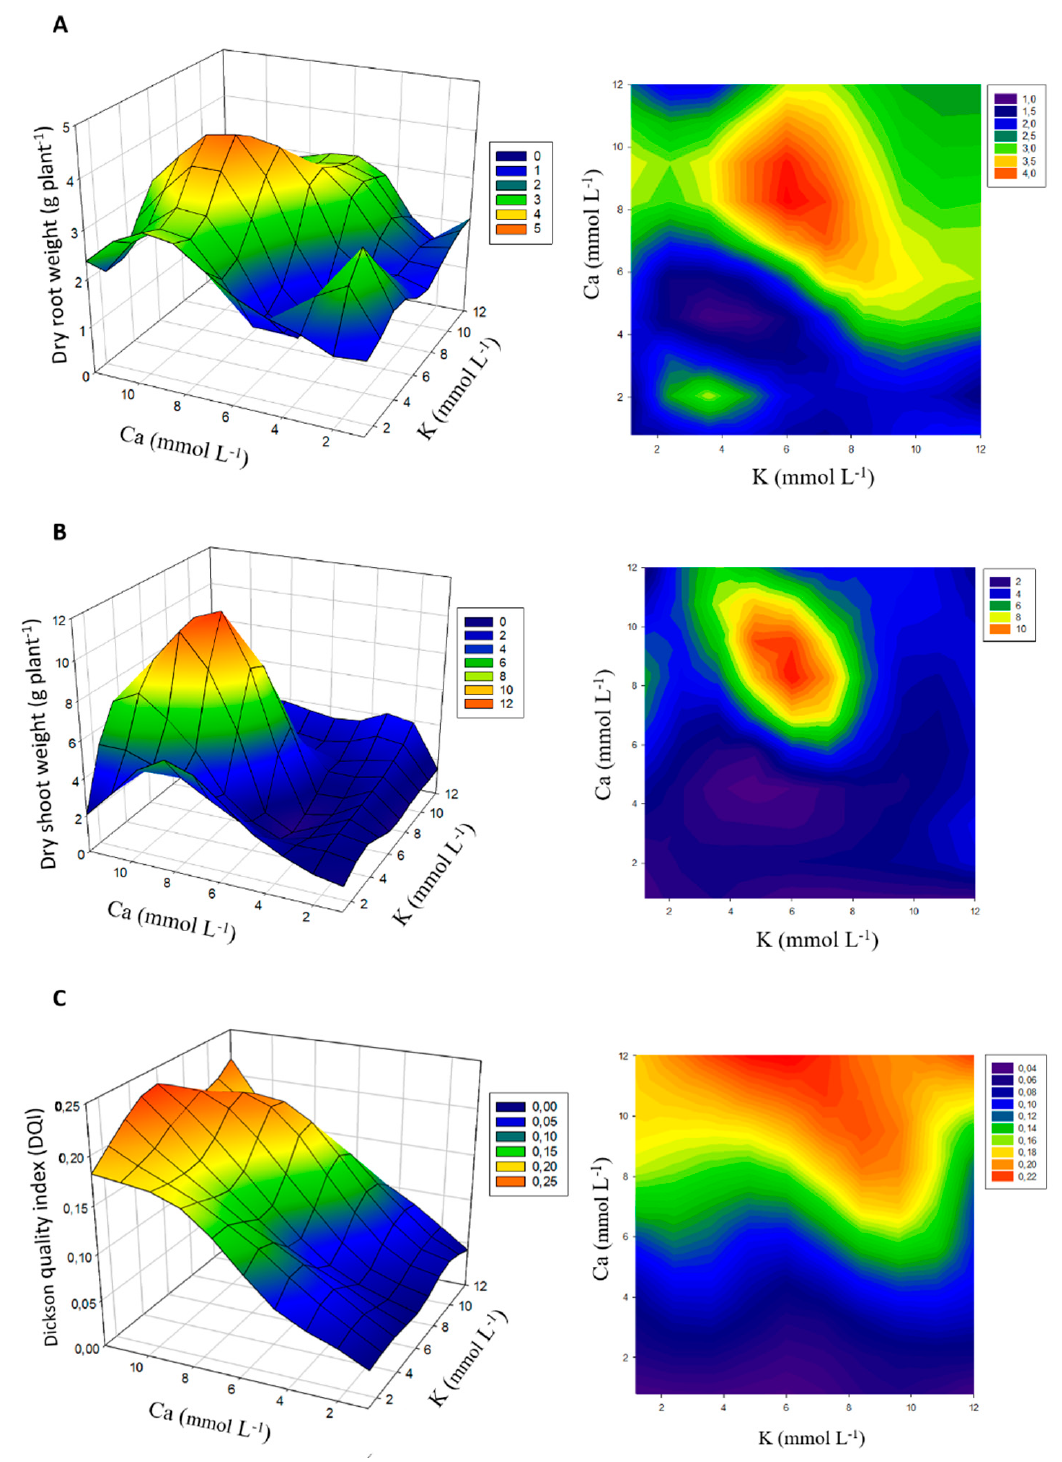
Figure 3. Influence of the supply of Ca and K (mmol L − 1 ) on the dry root weight (g plant − 1 ) ( A ), dry shoot weight (g plant − 1 ) ( B ) and Dickson quality index (DQI) ( C ) of eucalyptus. An increase in the chlorophyll a and b contents (Figure 4) and H (Figure 5) was obtained with the supply of Ca at a dose up to 8 mmol L − 1 and the supply of higher doses decreased the values of these